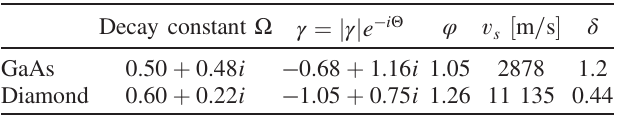
TABLE III. Derived properties for Rayleigh surface waves, for both GaAs and